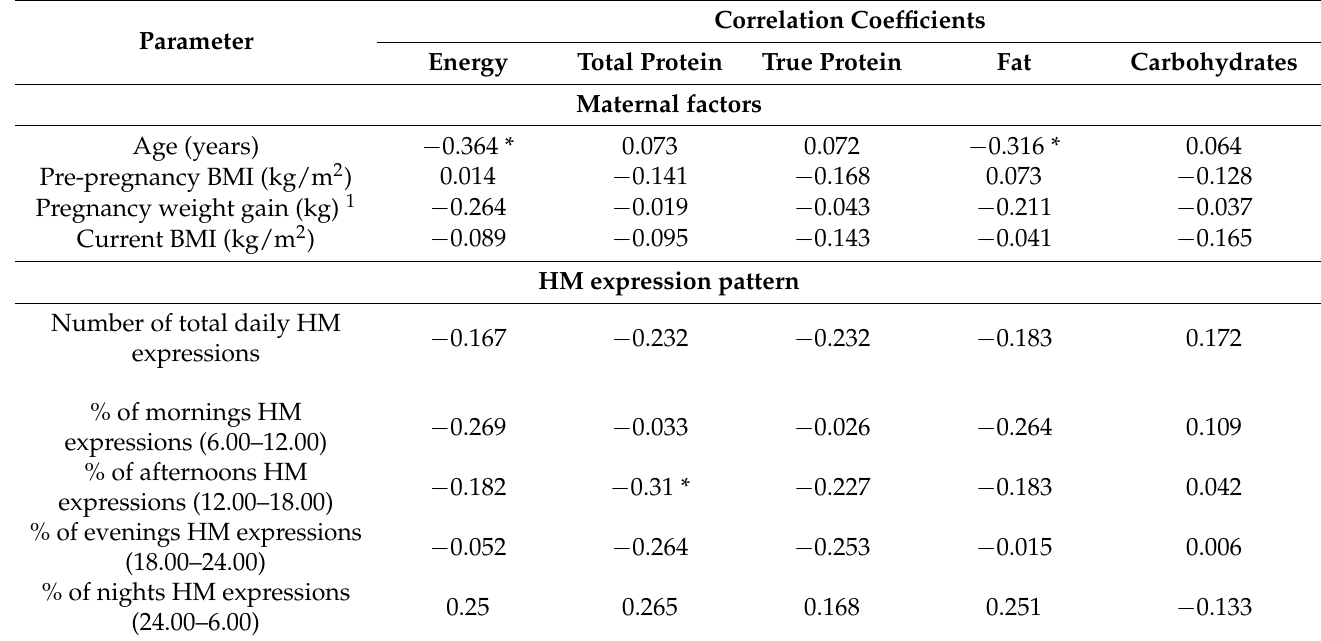
Table 4. Correlations 1 between maternal factors, HM expression pattern and DHM composition at the beginning of milk donation to HMB.